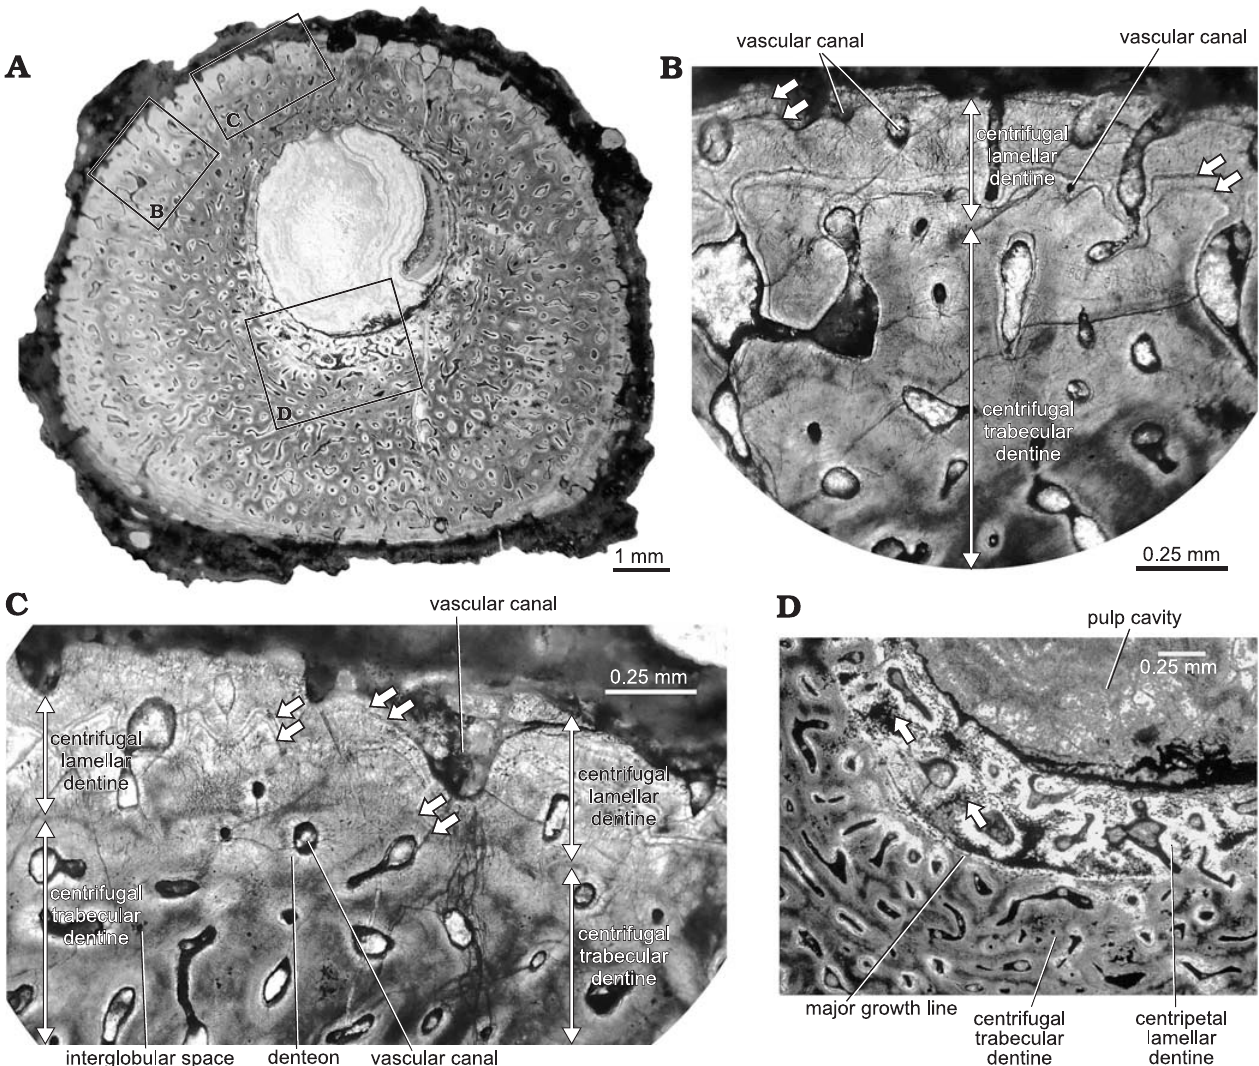
Fig. 7. Cross-section of dorsal spine of Orthacanthus platypternus (Cope, 1884), Lower Permian, Craddock Bone Bed, Texas, USA; specimen HMNS-J7 (non-denticulated region) showing color-banding in centrifugal trabecular dentine and growth lines in lamellar dentine. A . General view (posterior side of spine towards the top of the figure). B , C . Details of periphery showing pairs of growth lines (marked by arrows) in the centrifugal lamellar dentine. D . Detail of interglobular spaces within the centripetal lamellar dentine (arrows denote interglobular